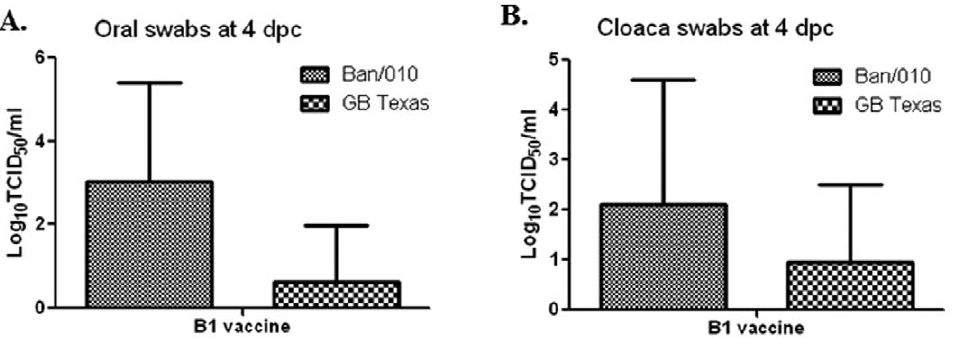
Figure 8. Shedding of Ban/010 or GB Texas challenge virus in 1-day-old chicks previously immunized with Ban/AF or B1. From the experiment shown in Fig. 7, oral and cloaca swabs were collected at 4, 6 and 8 days post-challenge, and samples were assayed for virus detection by inoculation into 9-day embryonated chicken egg. Samples that were positive in Table 7 were titrated by TCID50 assay. Note that virus was detected only in B1-vacciniated chicks.